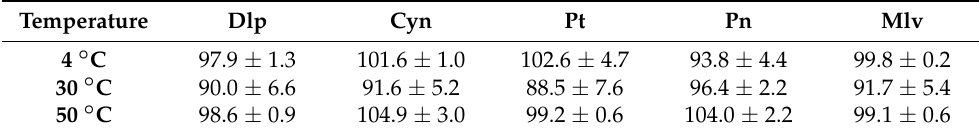
Table 2. Recovery (%) of anthocyanins extracted at different temperatures. Temperature